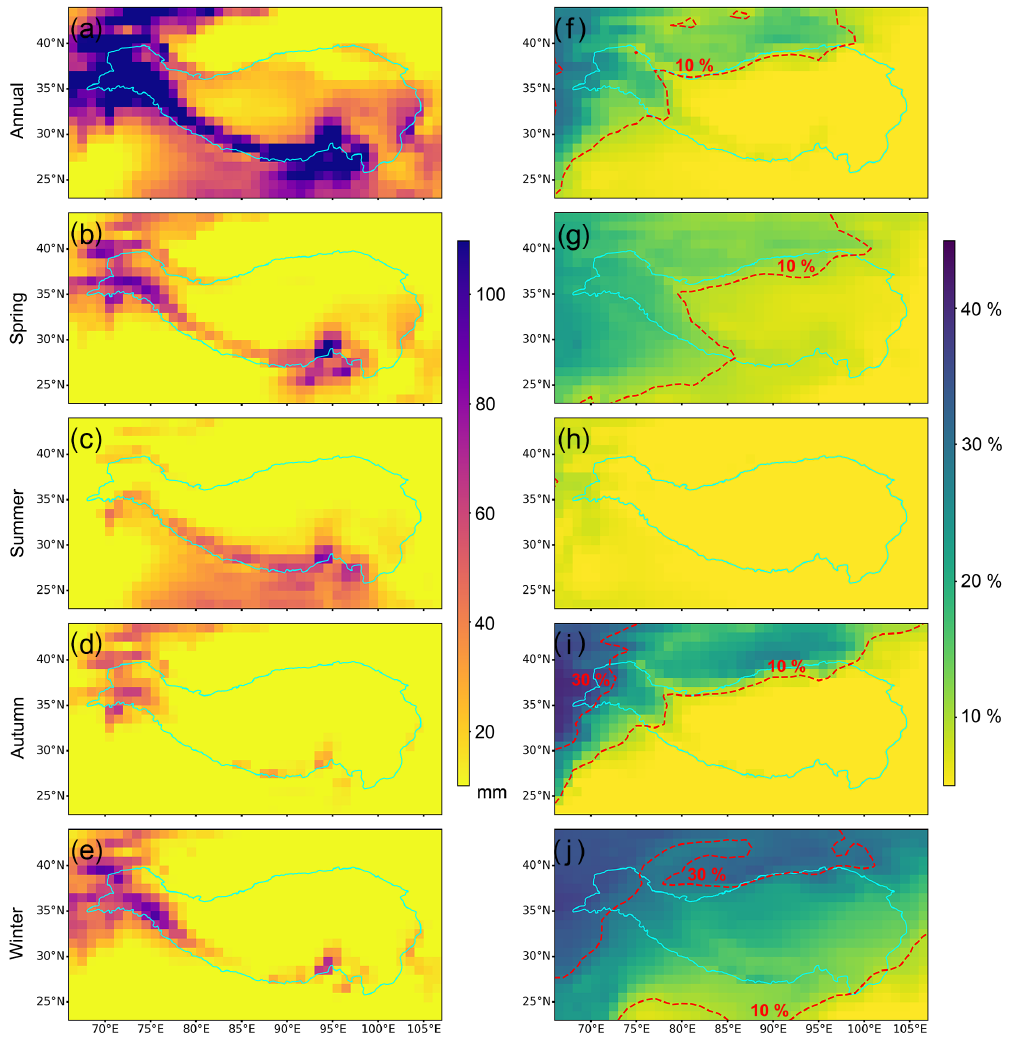
Figure 3. Spatial distributions of long-term mean absolute and relative moisture contributions from the western oceans (WO) to the TP precipitation. ( a – e ) The absolute contribution from the WO on annual (mmyr − 1 ) and seasonal (mmseason − 1 ) scales. ( f – j ) The relative contribution of the WO moisture on annual and seasonal scales. The dashed red lines in ( f – j ) are 10% and 30% isolines of the relative contribution. The forward moisture tracking results are modeled using WAM-2layers driven by ERA-Interim during 1979–2015. Moisture- tracking results driven by MERRA-2 (1980–2015) and JRA-55 (1979–2015) are shown in Figs. S7 and S8,